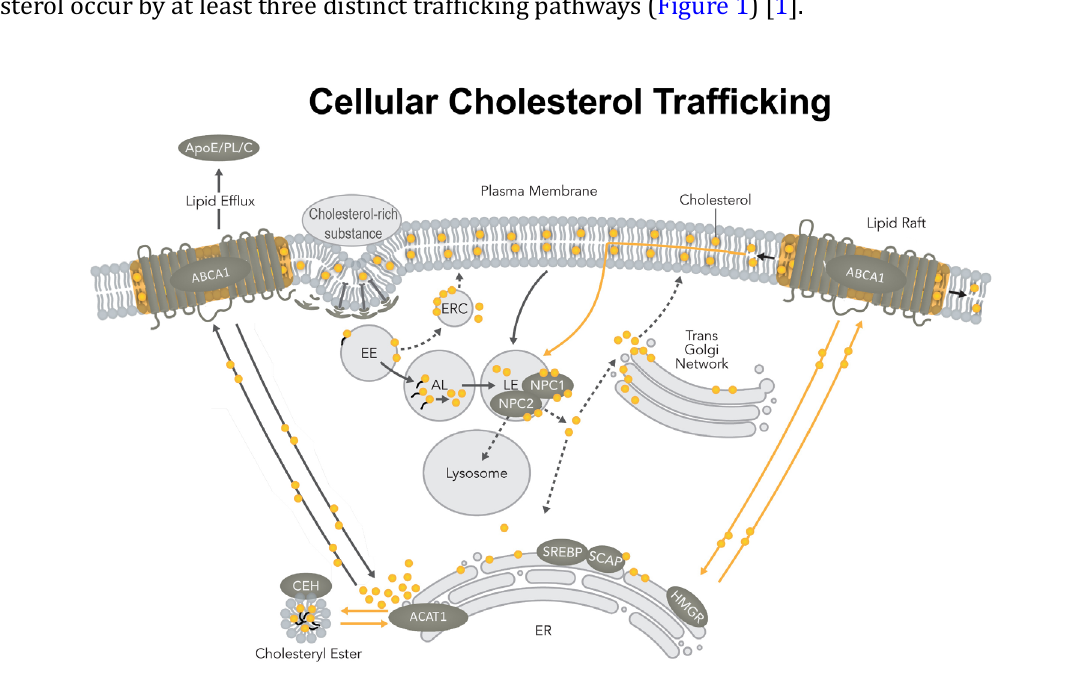
Figure 1. The cellular cholesterol trafficking pathway in a mammalian cell. ABCA1: ATP-binding cassette transporter 1 apolipoprotein E; AL: acid lipase; C cholesterol CEH: cholesterol ester hydrolase; EE: early endosomes; ERC: endocytic recycling compartment; HMGR: HMG-CoA reductase receptors; LE: late endosomes; NPC: Niemann-pick type C proteins; PL: : ; phospholipid; SREBP: sterol-regulatory-element binding protein; SCAP: SREBP cleavage activating protein Note. Adapted from “Cellular cholesterol homeostasis and Alzheimer’s disease,” by Chang TY, Yamauchi Y, Hasan MT, Chang